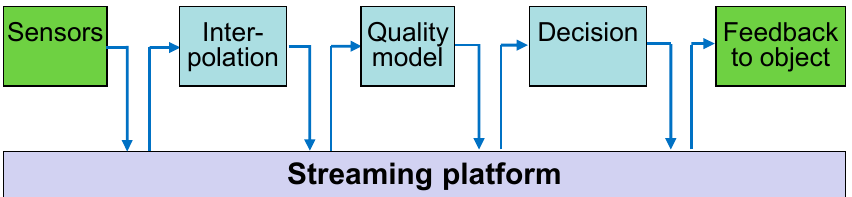
Figure 1. Linear chain/pipeline of three models and connection to the real world via publishing and subscription to a streaming platform.